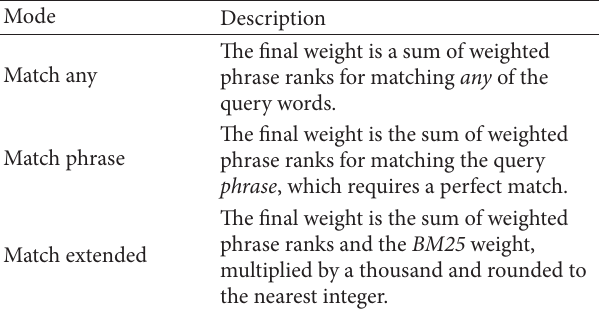
Table 2: The sphinx search modes.